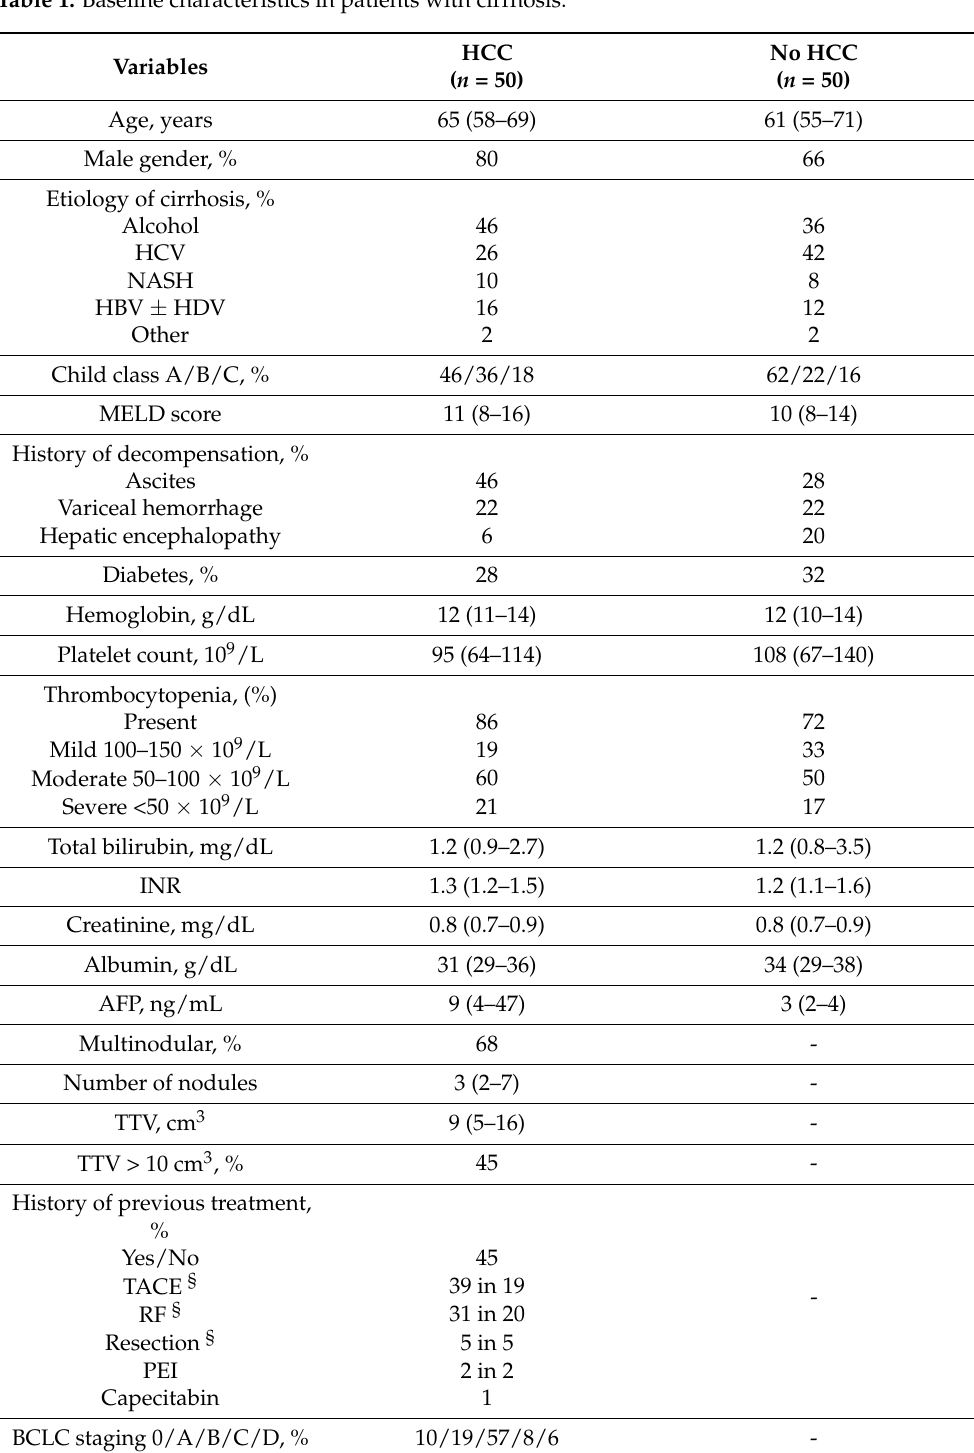
Table 1. Baseline characteristics in patients with